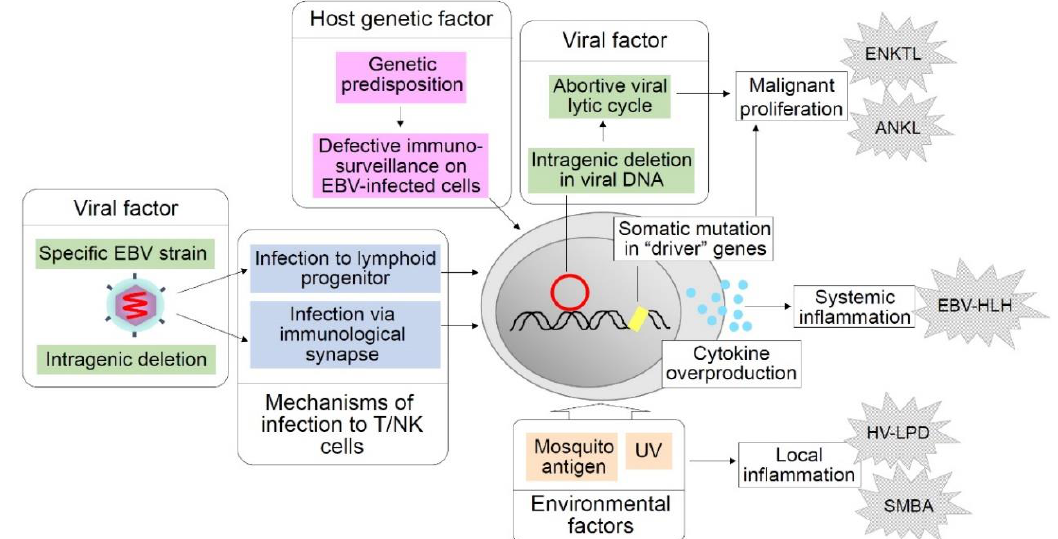
Figure 1. Hypothetical factors and events in chronic active Epstein–Barr virus (CAEBV) pathogenesis. Shown above are factors and events supposed to play critical roles in the pathogenesis of CAEBV and related EBV-positive T/NK-cell LPDs that may develop in the clinical course of CAEBV. Host genetic factors are supposed to impair immunosurveillance on EBV-infected cells. A possible viral strain predisposed to T/NK-cell lymphoproliferation is considered a viral factor. Intragenic deletions of the EBV genome that facilitate an abortive lytic cycle are presumed to enhance oncogenesis. Mosquito antigens and UV light are environmental factors that are thought to induce local inflammation such as hydroa vacciniforme (HV)-like LPD and severe mosquito bite allergy (SMBA). Infection to lymphoid progenitor cells and infection via immunological synapses are hypothetical mechanisms of EBV infection to T/NK cells.